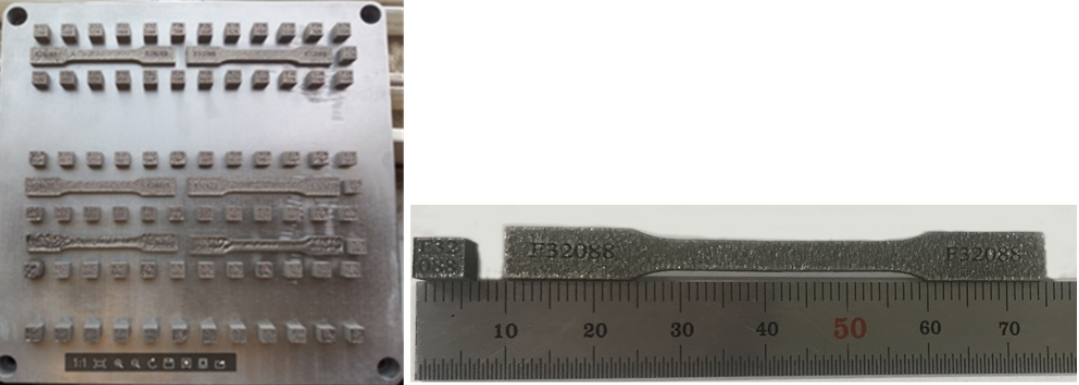
Figure 5. Photograph of the SLM-processed sample and tensile specimen.